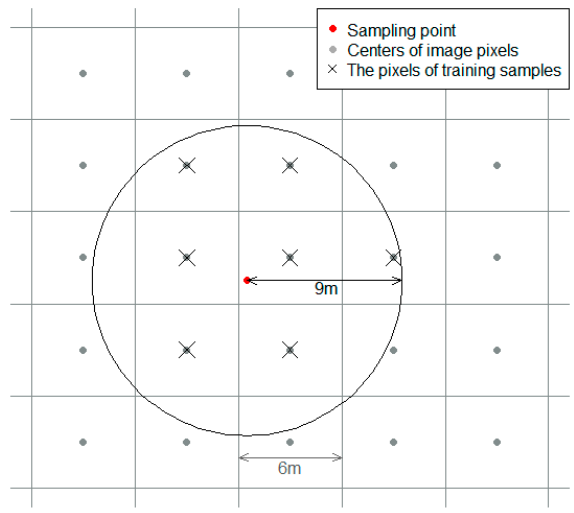
Figure 4. A diagram of training samples.